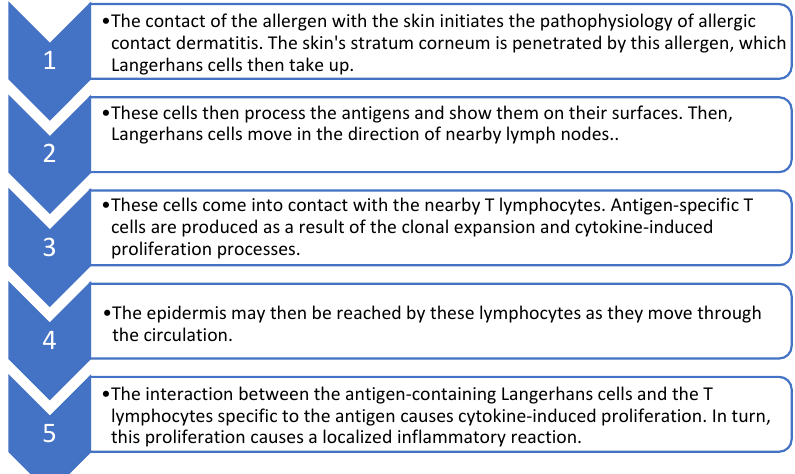
Figure 1. The pathophysiology of contact dermatitis [22] .